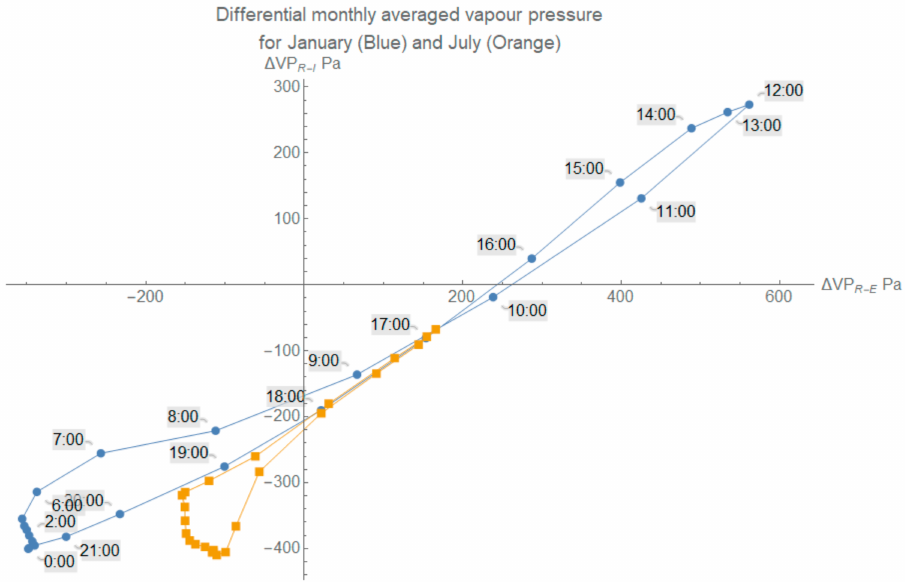
Figure 12. Water vapour pressure difference between the roof cavity and the inside ( ∆ VP R-I ) and the external climate ( ∆ VP R-E ) for one of the PHS dwellings and for a summer (blue) and winter (orange) month. Recordings in quadrant I ( top right ) mean that the roof cavity water vapour pressure is higher than the outside and the inside. Quadrant III ( bottom left ) has the opposite situation.